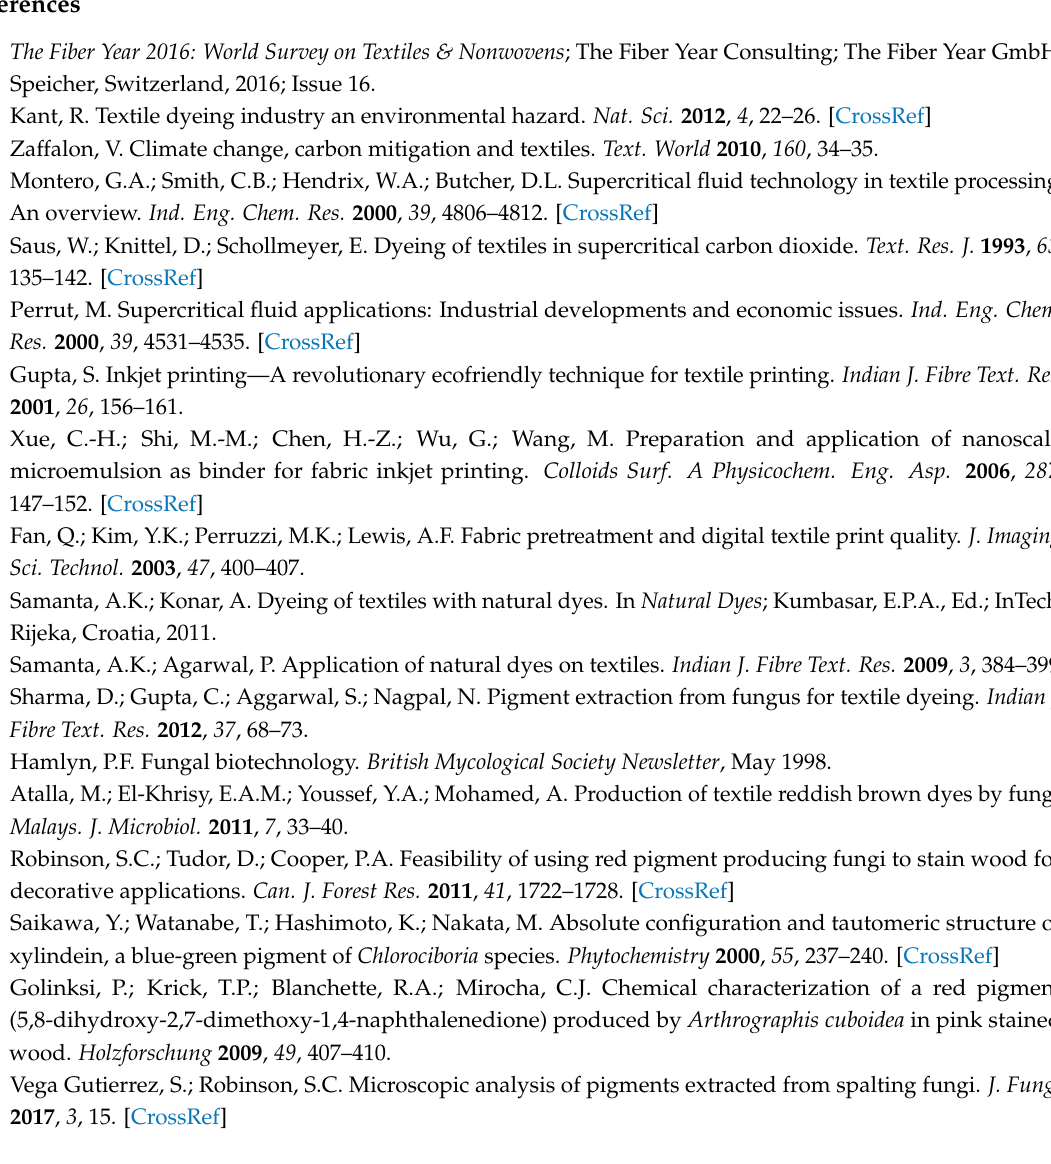
Table S1: Average delta E values for the dripping test, by material; Figure S1: Interaction graph (delta E values) for number of drops by fabric type; Figure S2: Delta E values for the dripping test, by fabric. Different letters represent statistical difference at alpha = 0.05. The highest delta E value for polyester was 43.99, the highest for cotton: 44.81, and the highest for nylon: 36.42; Figure S3: Delta E values by number of drops in the dripping test. Different letters represent statistical difference at alpha = 0.05; Figure S4: An interaction graph showing the delta E values across fabrics for the submersion test; Figure S5: Delta E across fabrics in the submersion test. Different letters represent statistical difference at alpha = 0.05; Figure S6: Delta E values by time of reading in the submersion test. Different letters represent statistical difference at alpha = 0.05; Figure S7: Delta E values by color across polyester, nylon, and cotton in the saturation test. Different letters represent statistical difference at alpha = 0.05; Figure S8: Delta E values by number of drops in the saturation test. Different letters represent statistical difference at alpha = 0.05; Figure S9: An interaction graph for the delta E values in the saturation test (number of drops by fabric